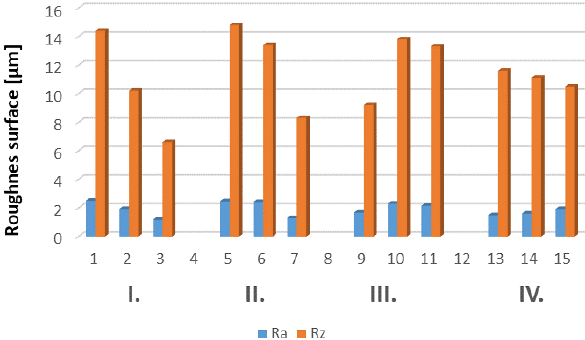
Figure 15: Display of values of the Ra dimension in individual quad- rants.